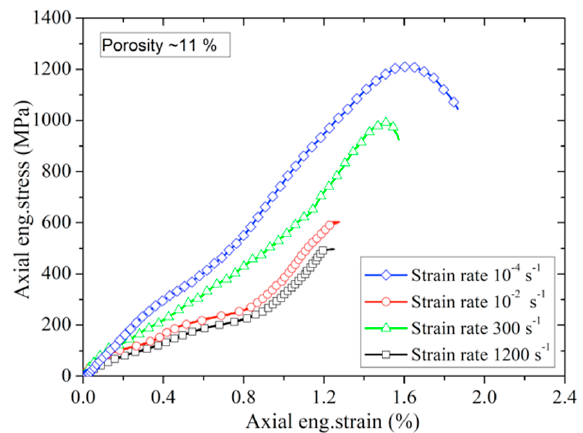
Figure 14. Eng.stress–eng.strain curves of porous poled ceramics at different strain rates.